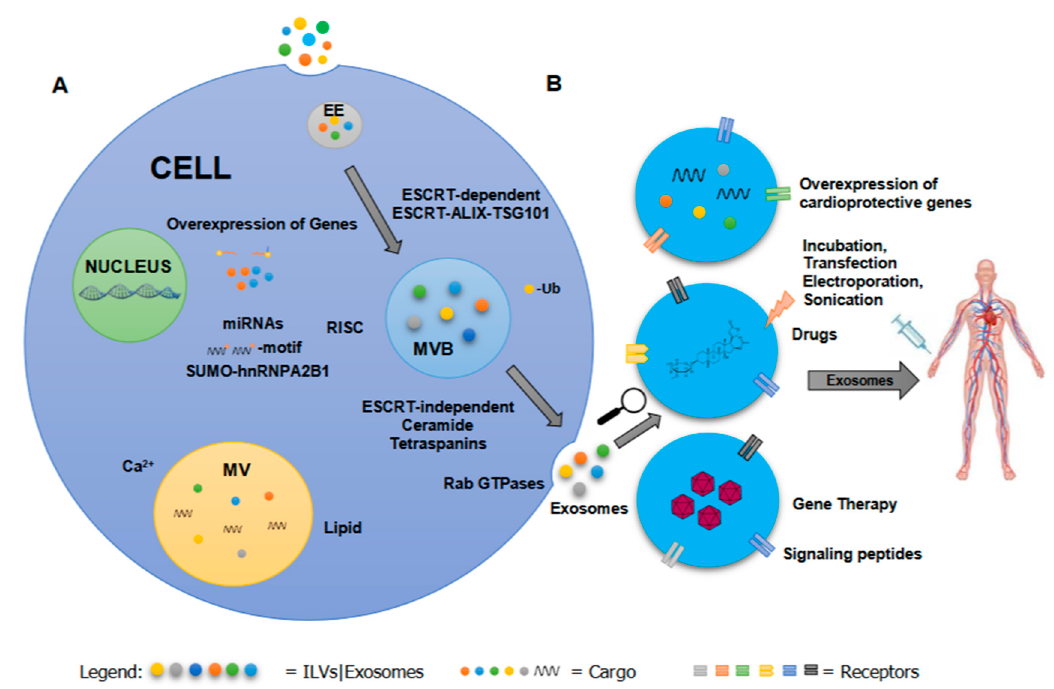
Figure 1. A summary of ( A ) EV cargo sorting and ( B ) methods for engineering exosome-based therapeutics to treat cardiovascular disease. EV cargo sorting is dependent on recognition signal or motif, post-translational modifications, and signaling molecules via ESCRT-dependent or -independent mechanism. Current methods in engineering EVs to incorporate therapeutic molecules include viral (e.g., overexpression of a gene using a viral vector, and delivery of a gene using a recombinant virus) or non-viral (e.g., incorporation of drugs or bioactive compounds by incubation or mechanical means, and alteration of targeting peptides) approaches. Abbreviations: Extracellular Vesicle (EV), Endosomal Sorting Complex (ESCRT), Early Endosome (EE), Multivesicle (MV), Multivesicular body (MVB) .